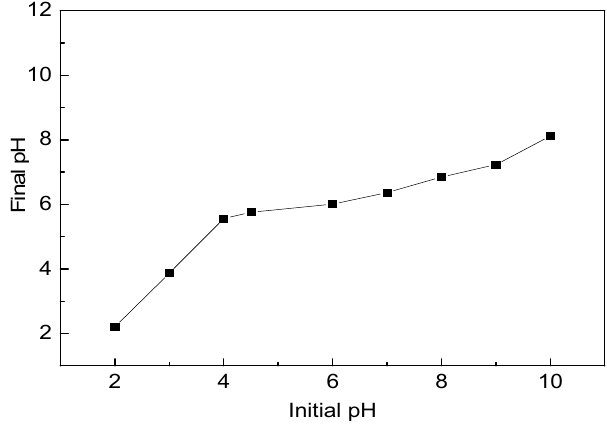
Figure 1. pH PZC of water hyacinth roots.